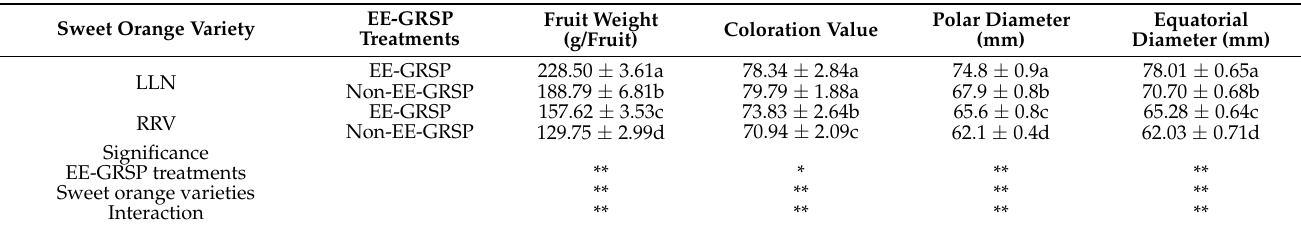
Table 2. Application response of exogenous EE-GRSP on the external fruit quality parameters of late-ripening sweet oranges. Sweet Orange